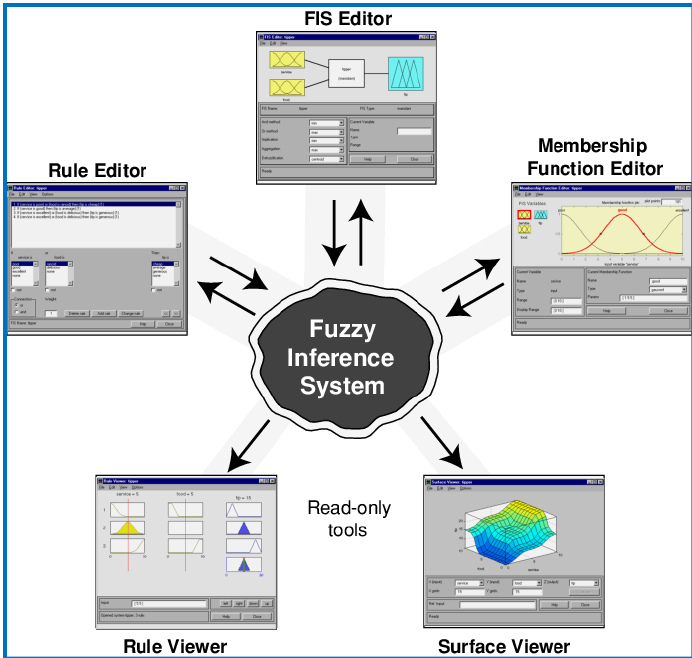
Figure 3. Fuzzy inference system.